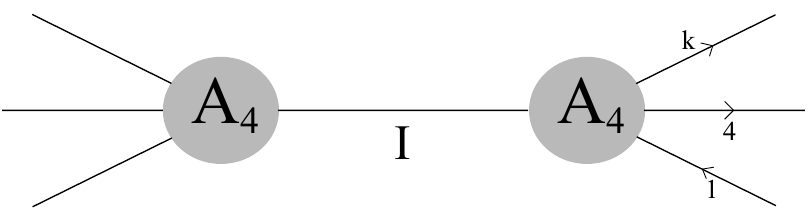
Figure 2 . Sketch of a factorization channel with spurious pole 1 / ( a 4 − a 1 ) where particles 1 and 4 are on the same side with another outgoing particle k